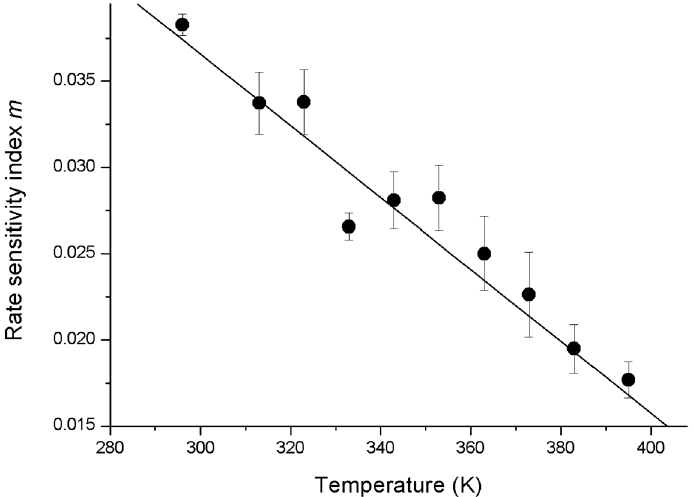
Figure 3. Dependence of the rate sensitivity index of the lower yield point on the test temperature.